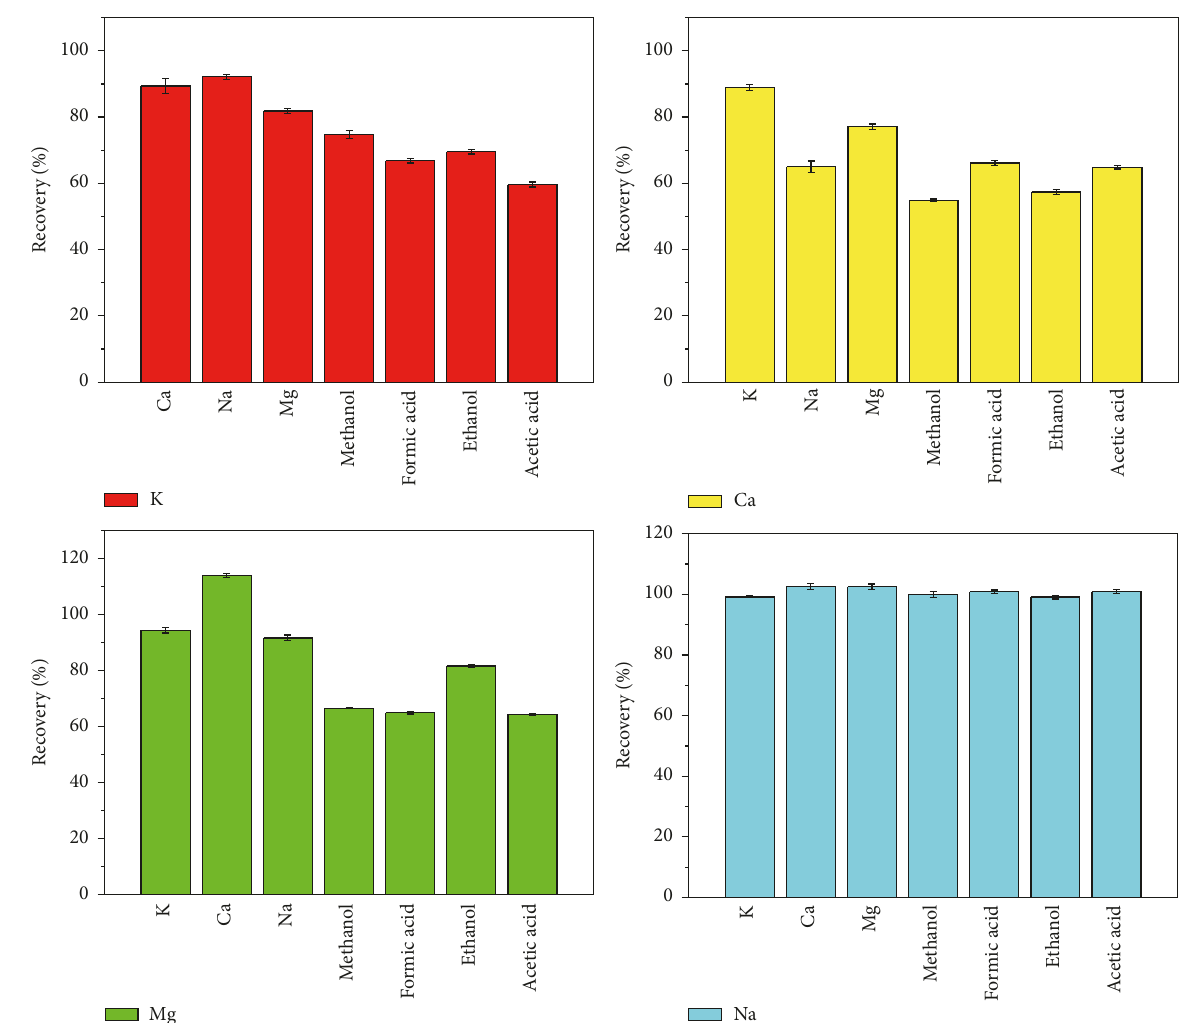
Figure 8: Mutual interference and the influence of organic matter (5mg L −1 K, Ca, Na, and Mg solution adjusted to pH = 1.0 with HNO 3 , discharge voltage: 650 V, flow rate: 3 mLmin −1 , interelectrode gap: 2mm, and capillary diameter: 1mm, added to 3% (volume ratio) methanol, ethanol, formic acid, and acetic acid and 50-fold K, Ca, Na, and